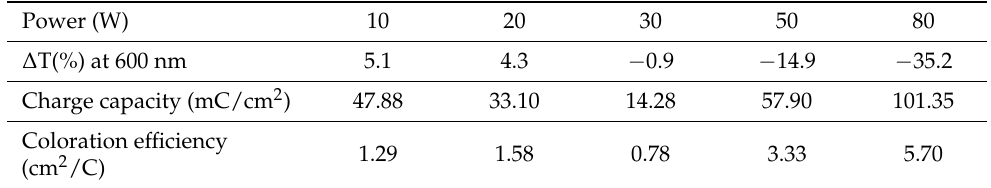
Table 2. The difference of the transmittance, the charge capacity and the coloration efficiency of the Ni-V-O film with respect to various of powers toward the Ni target.